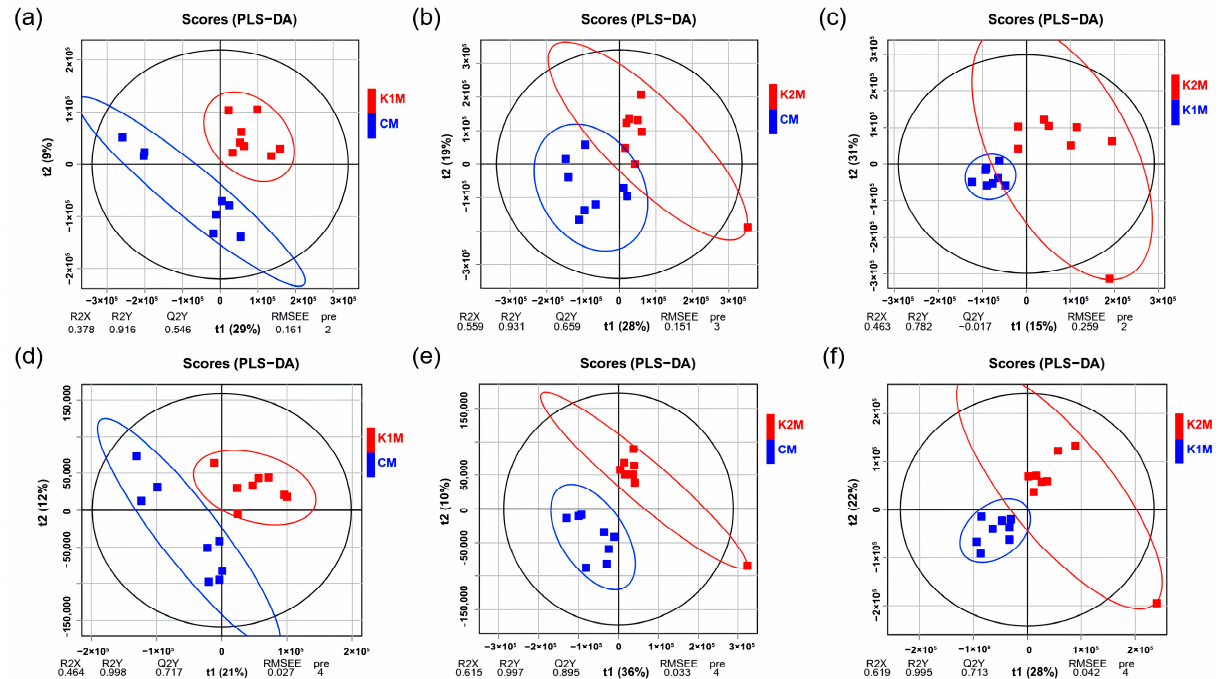
Figure 4. PLS-DA scores plot of longitudinal muscle metabolite profiling. ( a ) CM (in blue) vs. K1M (in red) in positive ion mode, Q 2 = 0.546; ( b ) CM (in blue) vs. K2M (in red) in positive ion mode, Q 2 = 0.659; ( c ) K1M (in blue) vs. K2M (in red) in positive ion mode, Q 2 < 0 (unreliable); ( d ) CM (in blue) vs. K2M (in red) in negative ion mode, Q 2 = 0.717; ( e ) CM (in blue) vs. K2M (in red) in negative ion mode, Q 2 = 0.895; ( f ) K1M (in blue) vs. K2M (in red) in negative ion mode, Q 2 = 0.713.